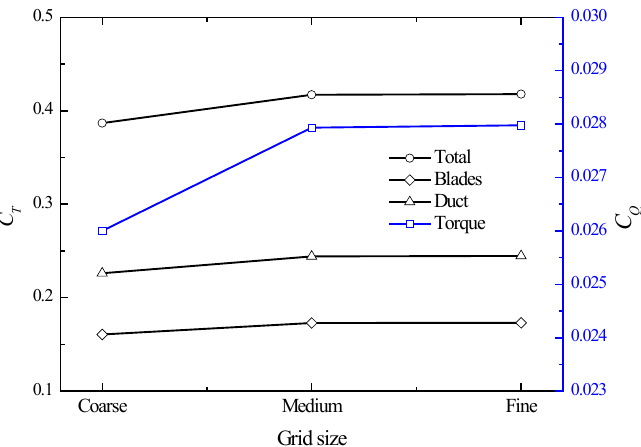
Figure 5. Comparison of results obtained with pressure inlet and velocity inlet boundary conditions: ( a ) force coefficients; ( b ) continuity residuals.